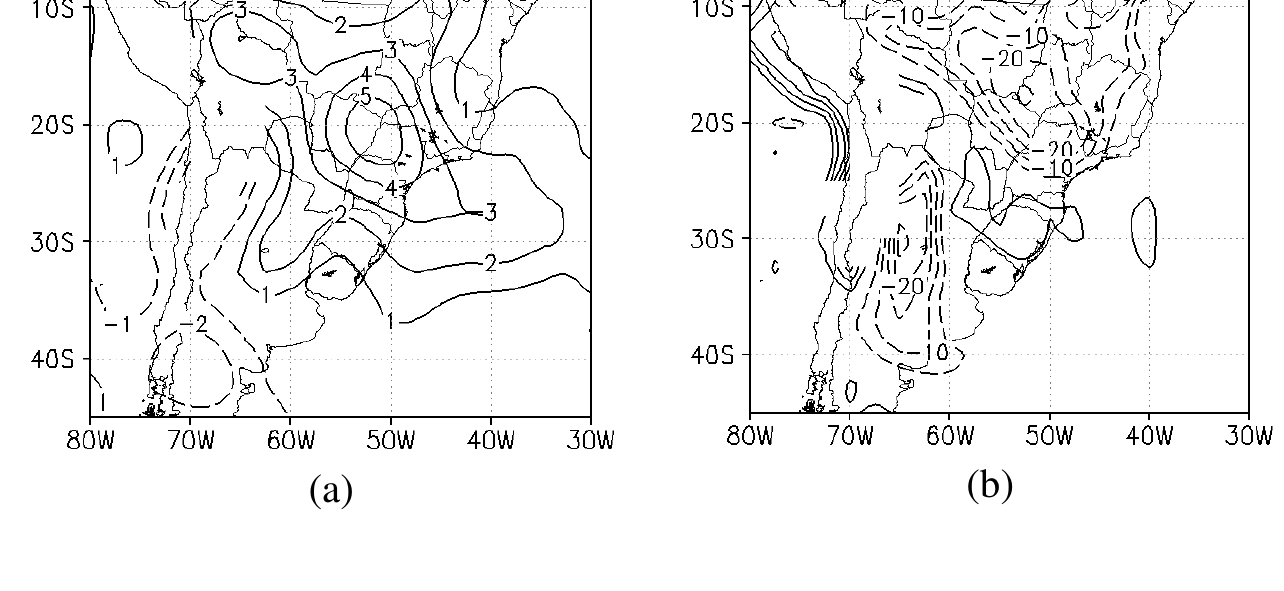
crosses the Andes on 10 June and moves on to the continent and later on to the Atlantic Ocean. The northward incursion of the frontal boundary associated with this trough has con- tributed for the dissipation of the WDS after 12 June. The sea-level-pressure and its anomaly sequences (not shown) also show some blocking-like characteristics in the Pacific. In this case, a surface front remains stationary over Uruguay, Paraguay and northern Argentina from 2 through 7 June. During this period the temperatures over Brazil